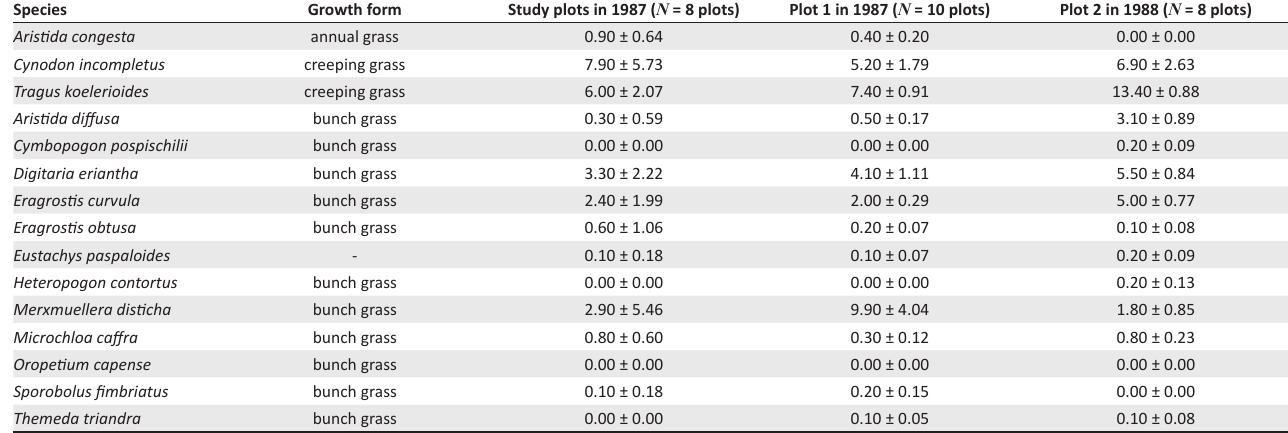
TABLE 1: Percentage canopy spread cover (mean ± standard error) of grass species compared between the study plots (four matching pairs of plots roughly 30 m by 30 m each) and Plots 1 and 2 (each 100 m by 100 m) which were used to determine the density of grazing ungulates using the area. Species Growth